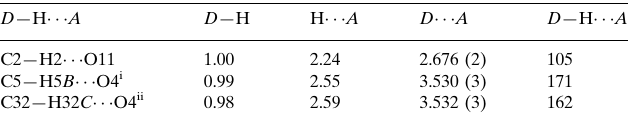
Hydrogen-bond geometry (A˚ , (cid:1)